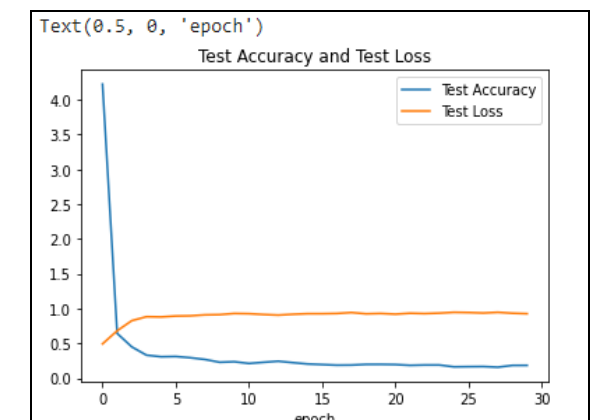
Figure 5: Test Accuracy and Test Loss